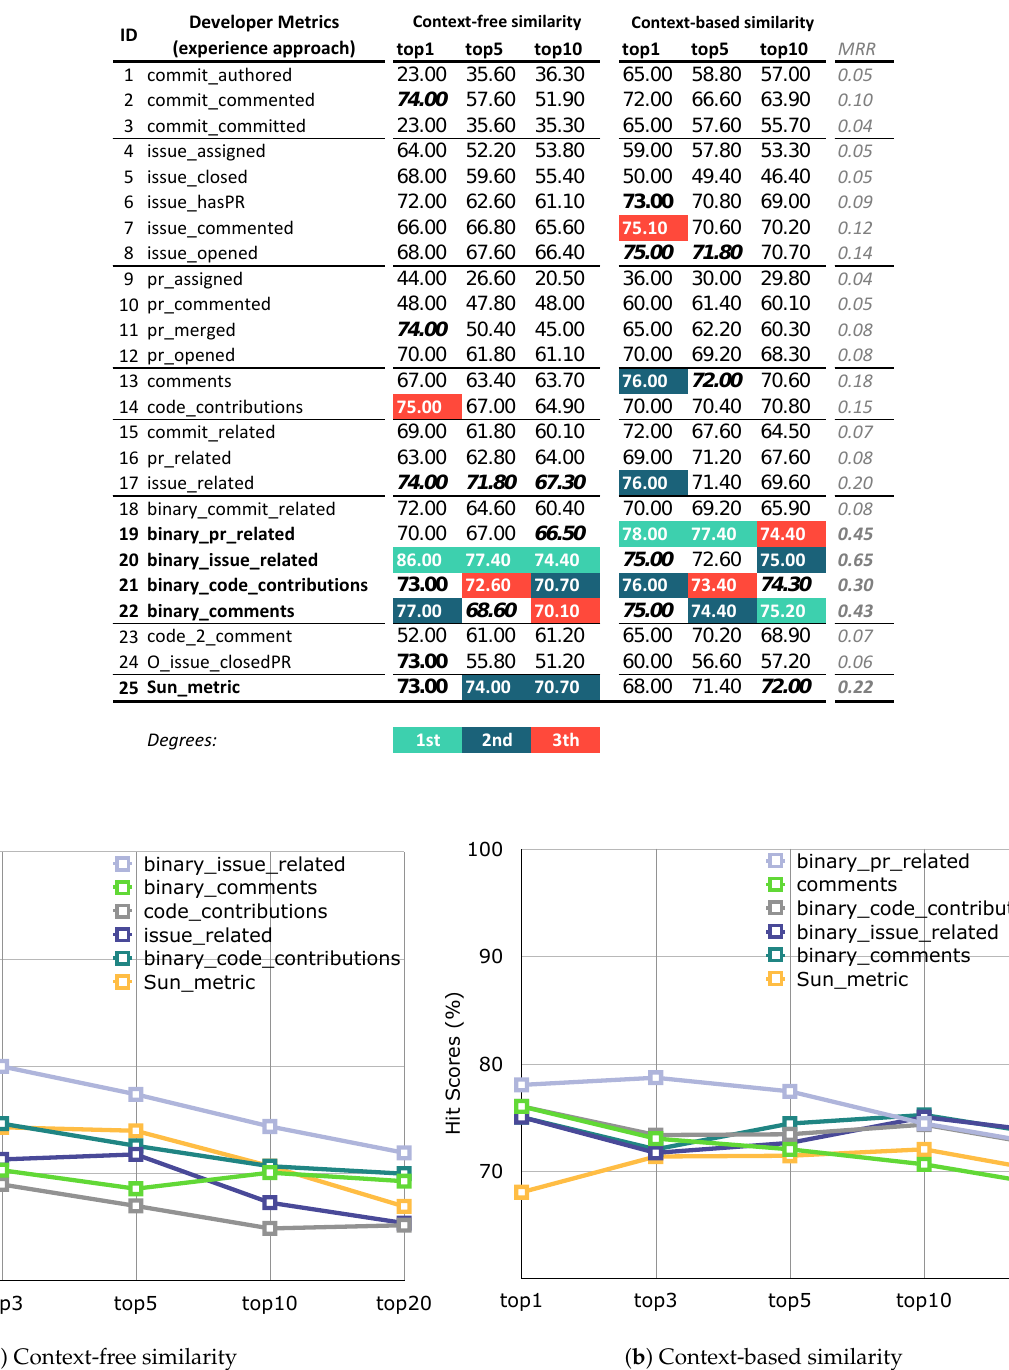
Table 10. Developer metrics scores according to evaluate with the language experience approach.